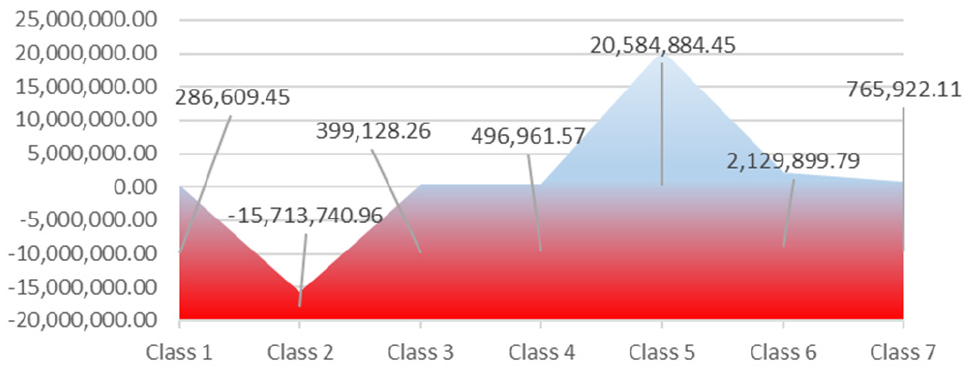
Figure 3. Regional capitalization of the companies at industry level during 2012–2017 (euros). Source: Authors’ processing based on the information provided on Topfirme.com. Accessed date: 5 June 2018.